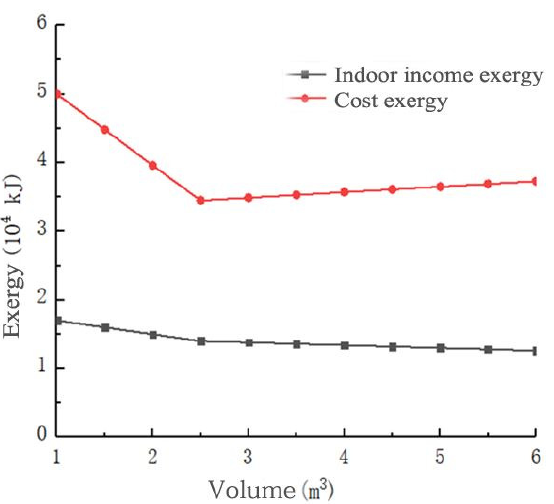
Figure 7. Variations of the cost and indoor income exergies with the volume of the phase-change heat-storage tank.